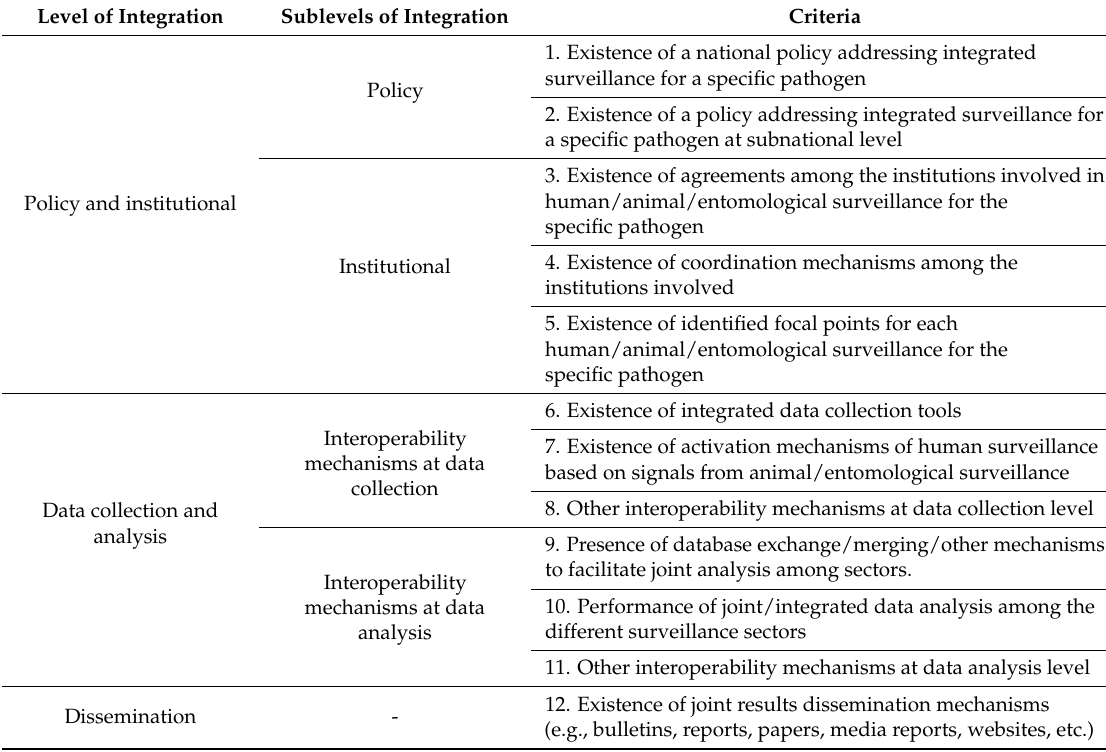
Table 1. Proposed criteria to assess existing levels of